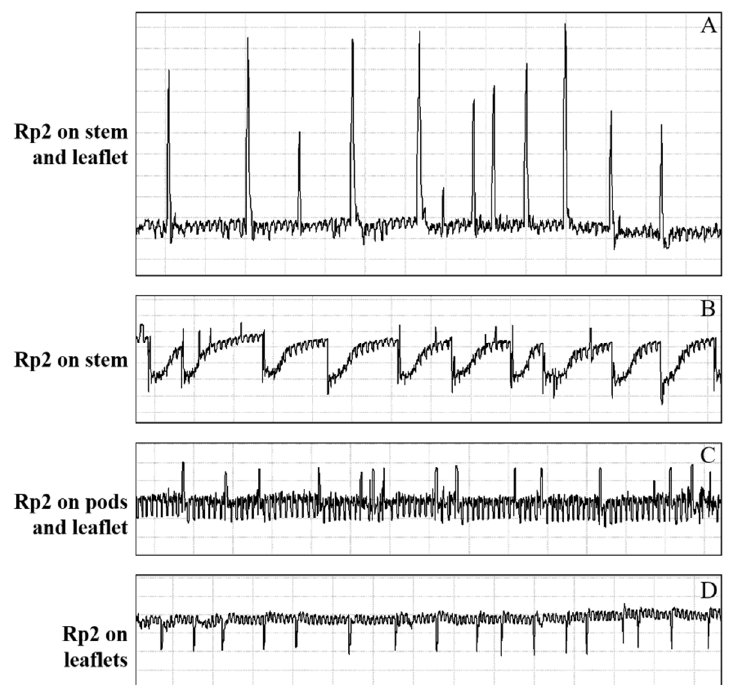
Figure 3. Detail of the waveform Rp2 recorded during feeding behavior of R. pedestris on soybean leaflet, stem, and pod. ( A ) Amplitude of Rp2 waves and peak orientation recorded on stem and leaflet with relative amplitude ( − 4.3– − 2.3). ( B ) Amplitude of Rp2 waves and peak orientation recorded on stem with relative amplitude ( − 0.2–0.3). ( C ) Amplitude of Rp2 waves and peak orientation recorded on pod and leaflet with relative amplitude ( − 0.6–0.3). ( D ) Amplitude of Rp2 waves and peak orientation recorded on lea fl et with relative amplitude ( − 3.5– − 3.3).